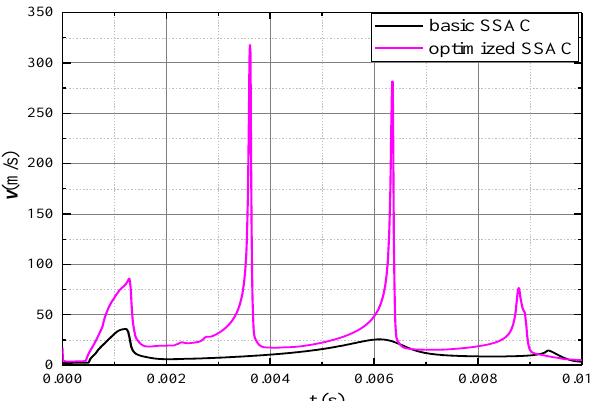
Energies 2018 , 11 , x FOR PEER REVIEW Figure 6. Airflow velocity of the basic SSAC and optimized SSAC. Figure 6. Airflow velocity of the basic SSAC and optimized SSAC.